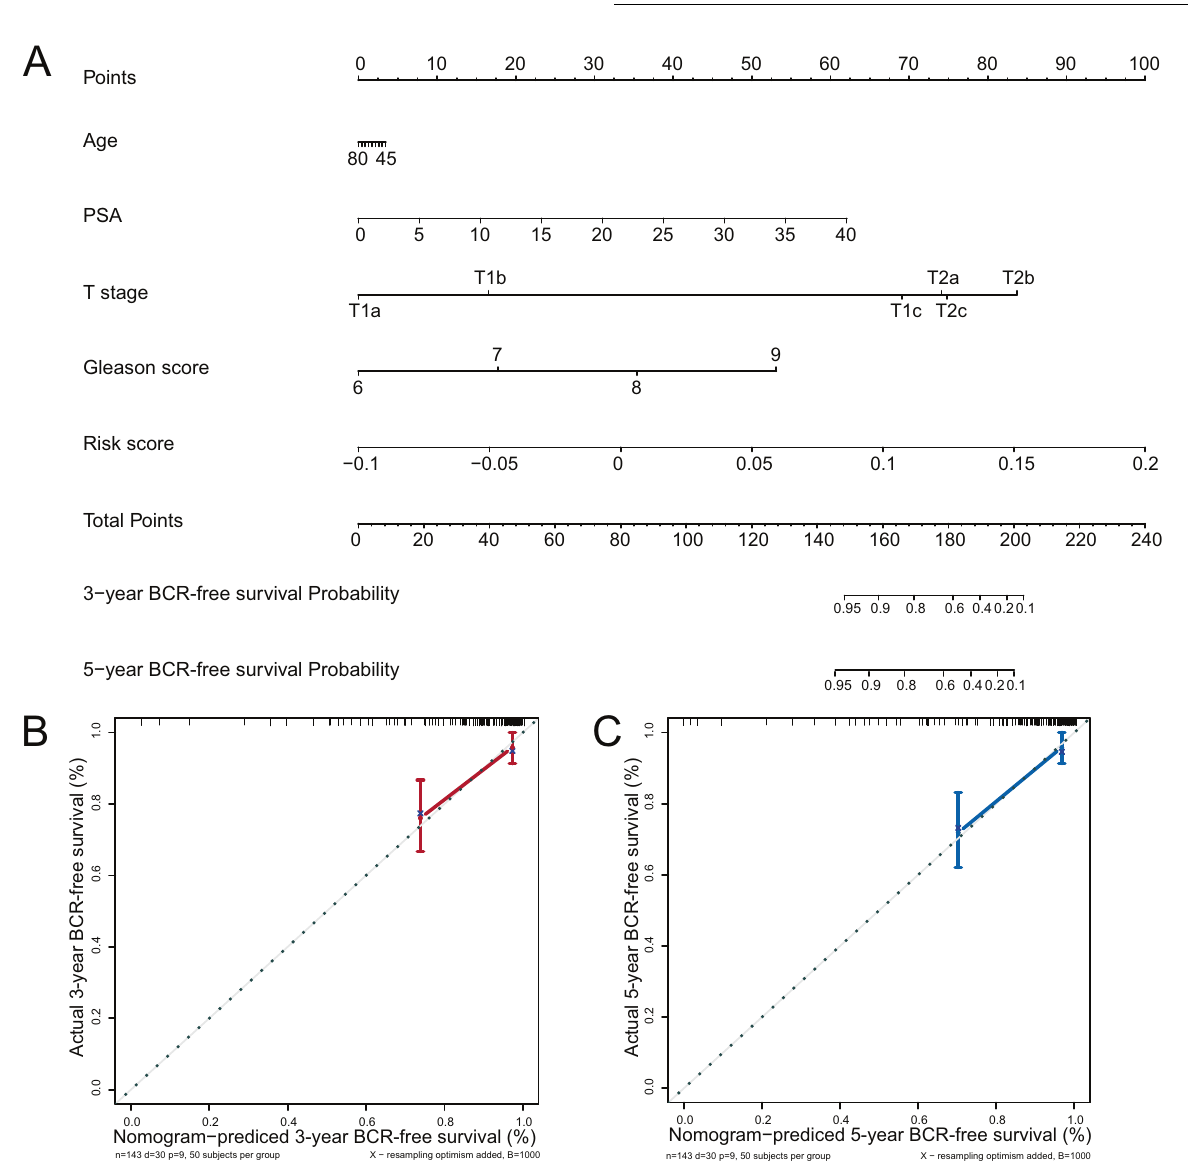
Fig. 5 Construction of a nomogram for BCR-free survival prediction. A The nomogram containing the risk score and clinicopathological features. B , C Calibration plot showing that nomogram-predicted 3- and 5-year BCR-free survival probabilities were in accordance with the actual observed